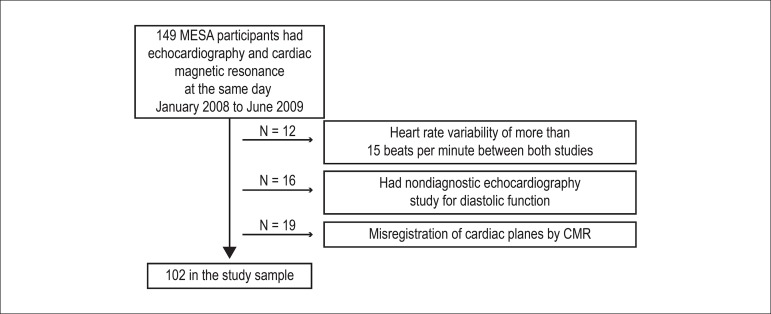
Flowchart of the study population. Abbreviation: CMR: cardiac
magnetic resonance.